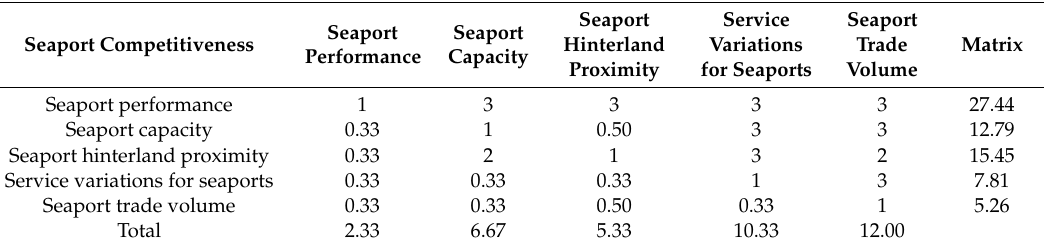
Table 10. Consistency test of port competitiveness criteria data.